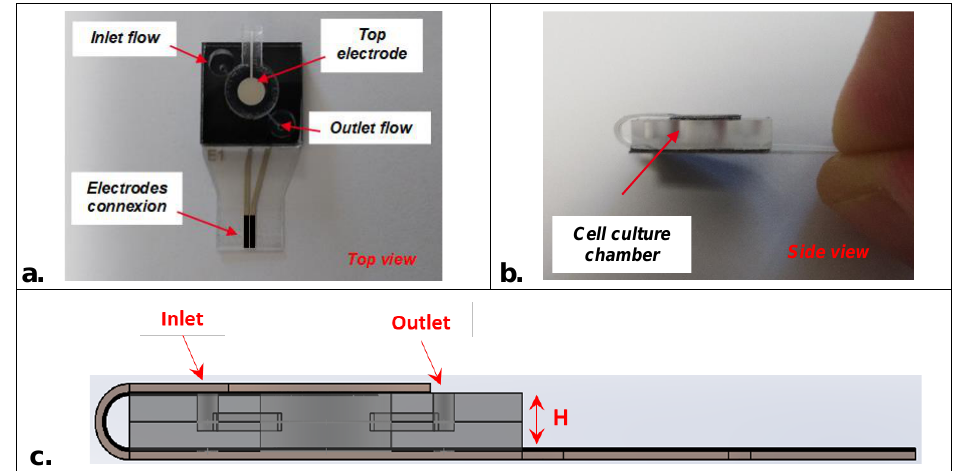
Figure 2. Design of the embedded microfluidic cell-culture chamber integrating the impedance sensors in ( a ) top view and ( b ) side view. ( c ) Schematic representation in section view of the assembled impedance sensors (H represents the depth of the cell-culture chamber).